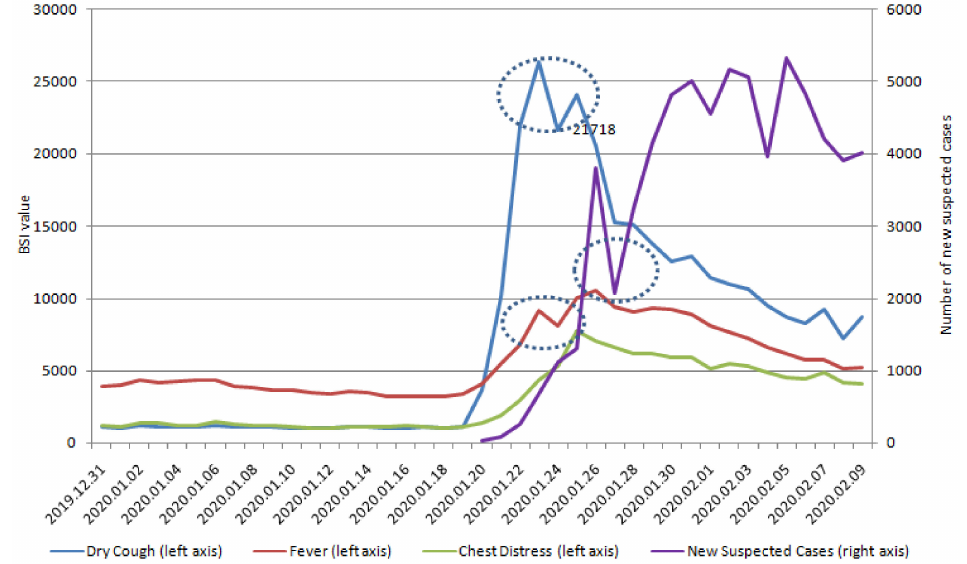
Figure 1. New suspected cases of COVID-19 and lag days of dry cough, fever, and chest